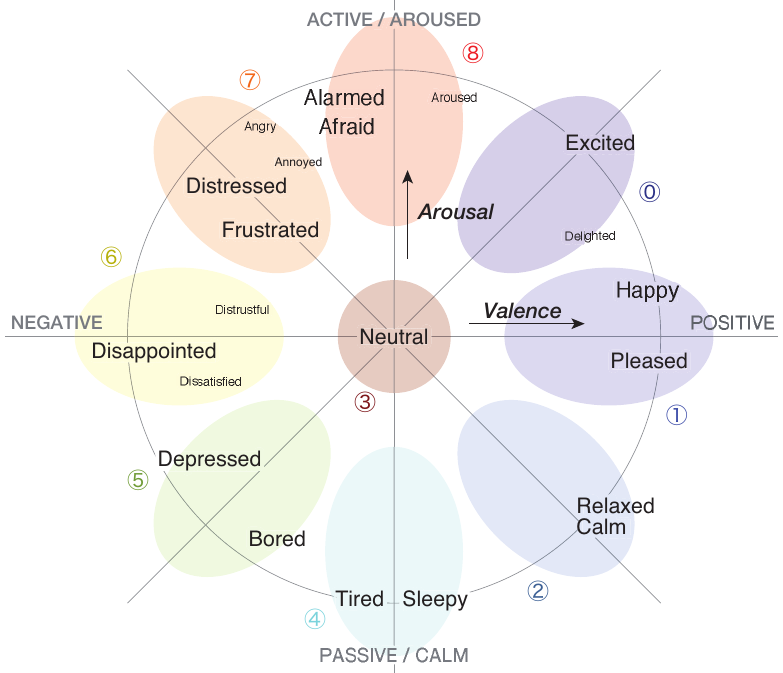
Figure 4. A two-dimensional emotion status model. Figure is taken from References